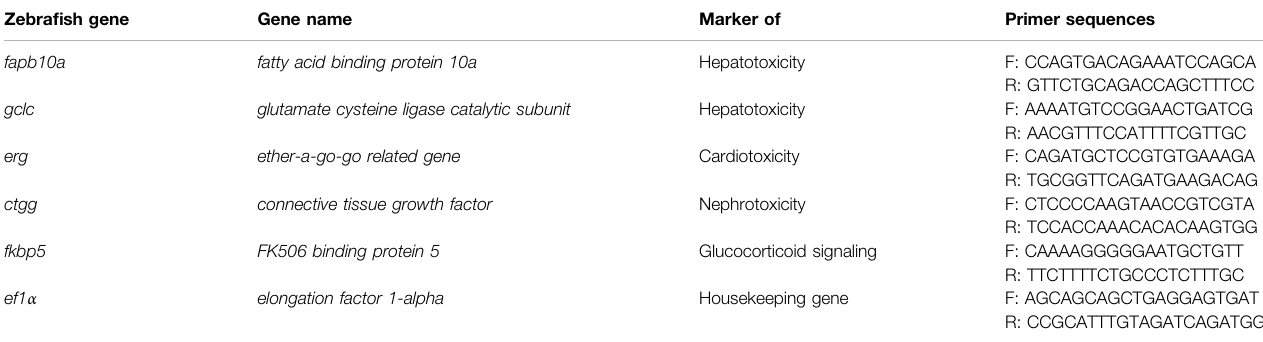
TABLE 1 | qPCR primer sequences. Zebra fi sh